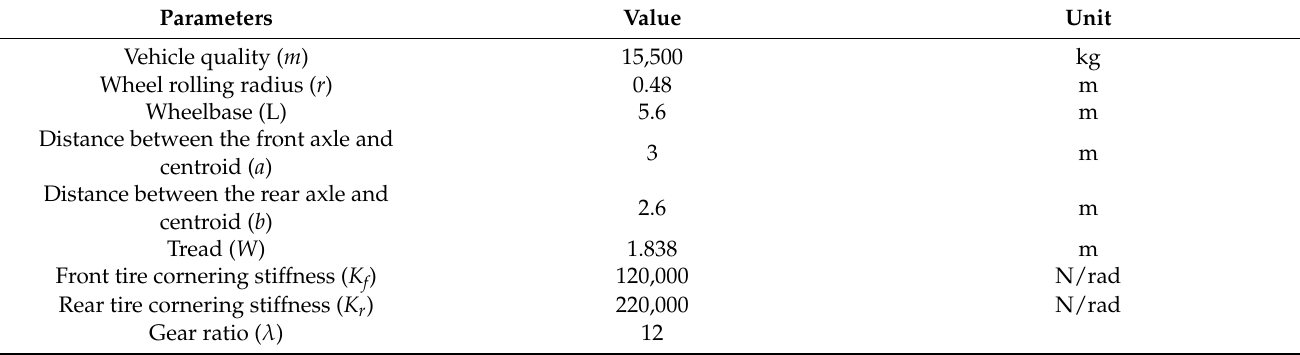
Figure 1. Configuration of DDEV using wheel motors. Table 1. Electric bus parameters.